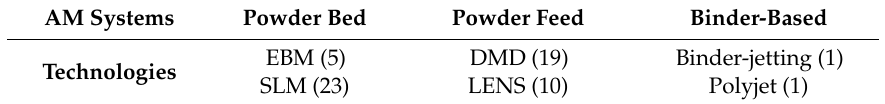
Table 1. AM systems and technologies (data from [10–12,15,16]) used for HEAs (number of